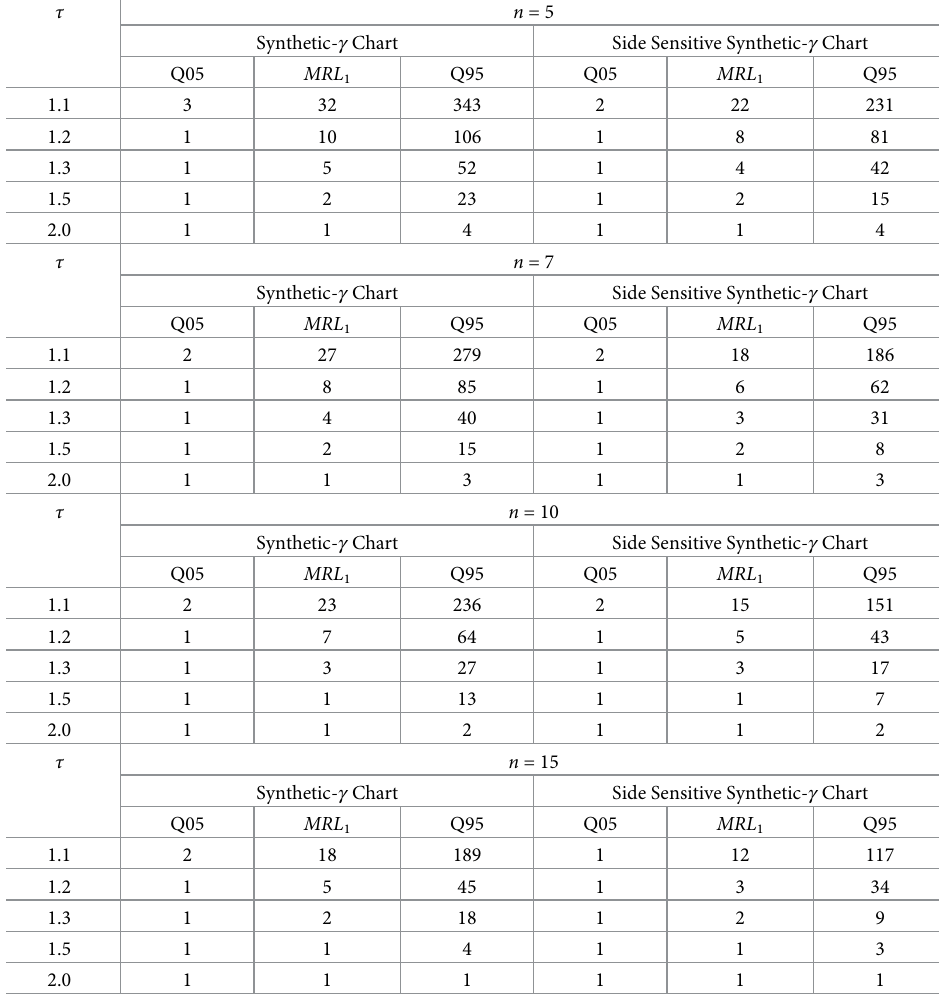
Table 9. Comparison of the Q05, MRL 1 and Q95 of the MRL -based synthetic- γ chart (without side sensitivity) and side sensitive synthetic- γ chart for γ 0 = 0.05, n 2 {5,7,10,15} and τ 2 {1.1,1.2,1.3,1.5,2.0}.